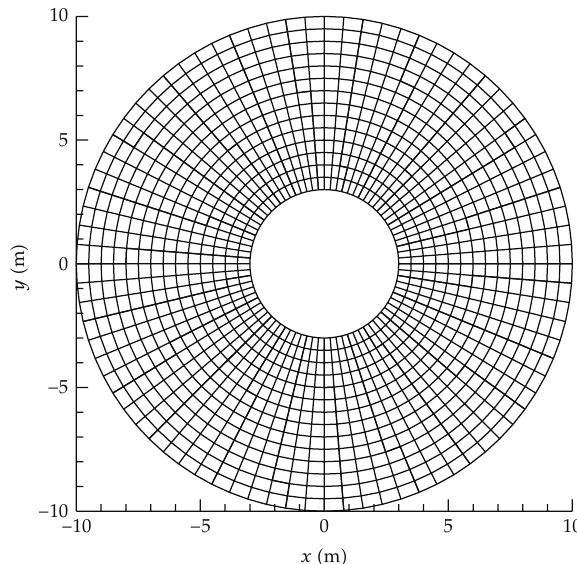
Figure 6: Grid system for coaxial cylindrical